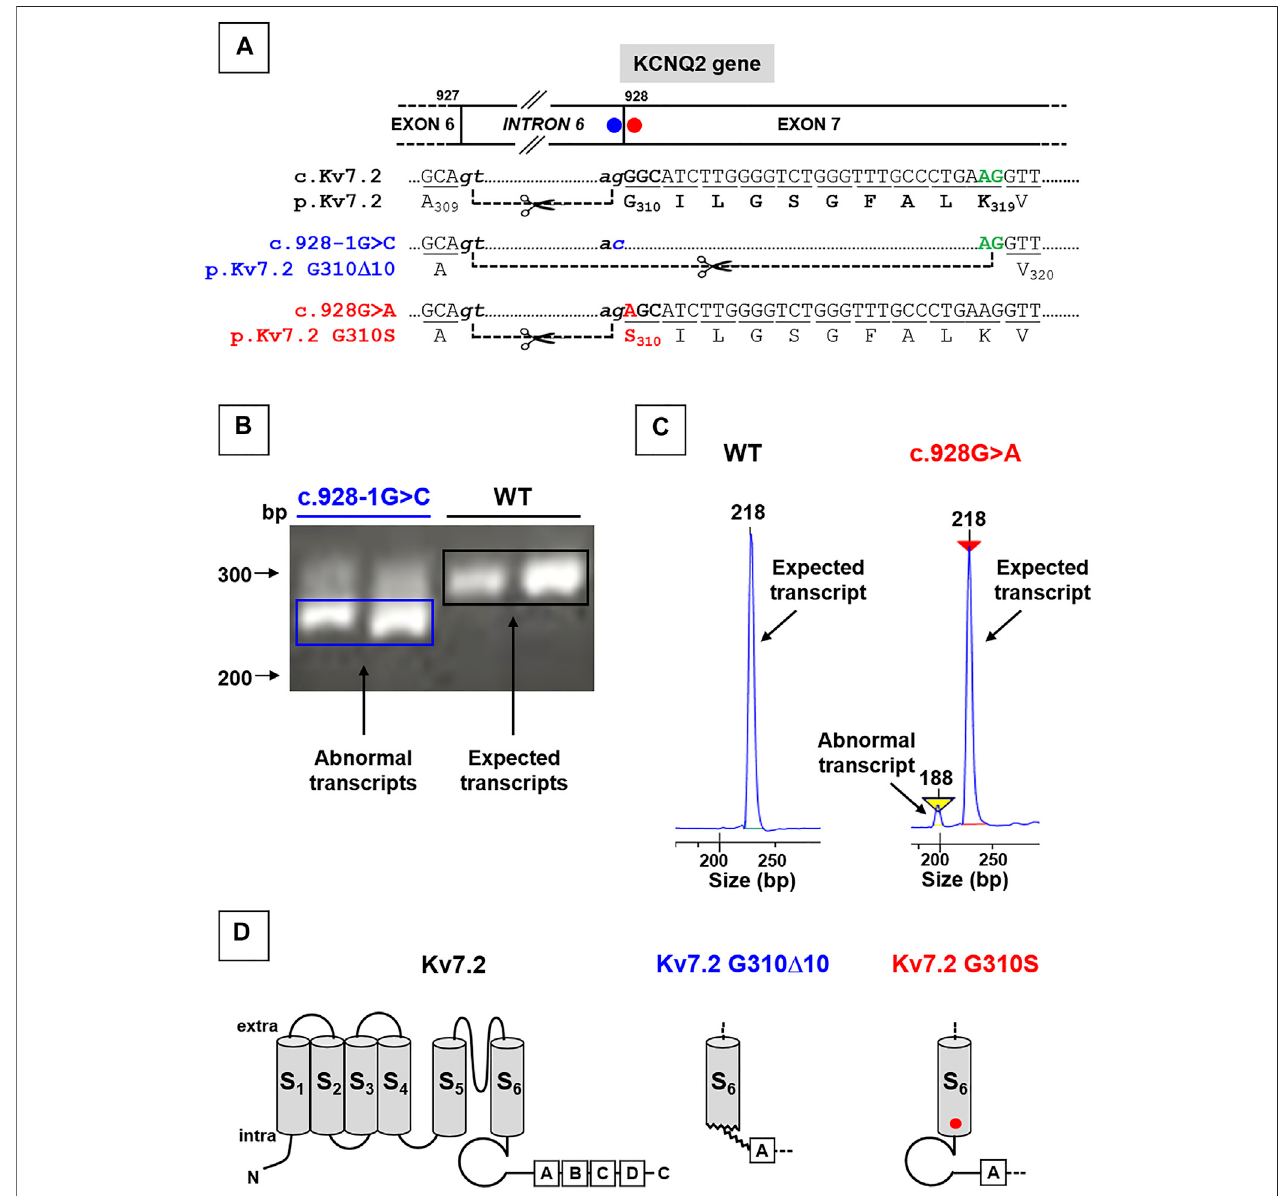
FIGURE1| Localization of KCNQ2 variants herein investigated and effects on KCNQ2 mRNAs expression. (A) Localization of the two variants herein investigated in the KCNQ2 gene, falling at the last nucleotide of intron 6 (KCNQ2 (C) 928-1G > C; blue circle; already reported in Soldovieri et al., 2014) or at the fi rst nucleotide of exon 7 (KCNQ2 (C) 928G > (A) ; already reported in Soldovieri et al., 2020). (B) Representative agarose gel run and (C) electrophoresis pro fi les of major bands obtained from RT-PCR experiments performed on Kv7.2 mRNAs expressed in father- or probands-deriving lymphoblasts, as indicated; the mRNA fragment of 295 bp (B) or 218 bp (C) are expected when the ag acceptor site at the end of intron 6 is used, while those of 265 bp (B) or 188 bp (C) bands are obtained using the alternative splice site in the exon 7. Panels in C have been obtained cropping the regions of interest from the complete electrophoresis pro fi les, reported in Supplementary Figure S2 Topology of a Kv7.2 subunit showing the 6 transmembrane segments (called from S1 to S6) and four intracellular domains at the C-terminus (called from A to D), binding many regulatory molecules. Middle and left panels show the structural alterations prompted by the Kv7.2 G310 Δ 10 in- frame deletion or by the missense Kv7.2 G310S variant,